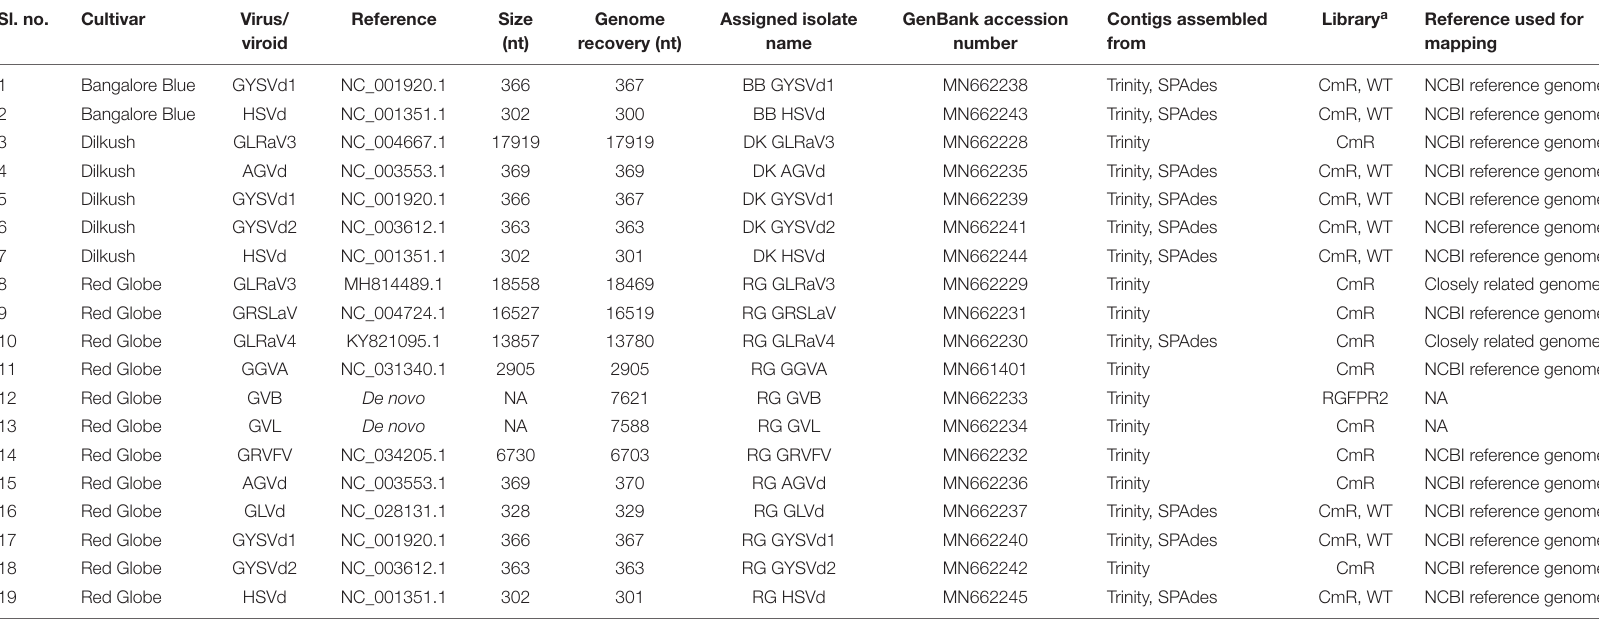
TABLE 2 | Summary of complete/near complete viral/viroidal genomes reconstructed from three Indian grapevine cultivars. Sl.